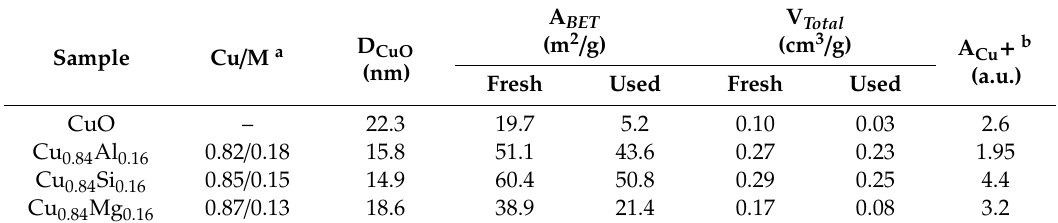
Table 1. Structural and textural properties of the